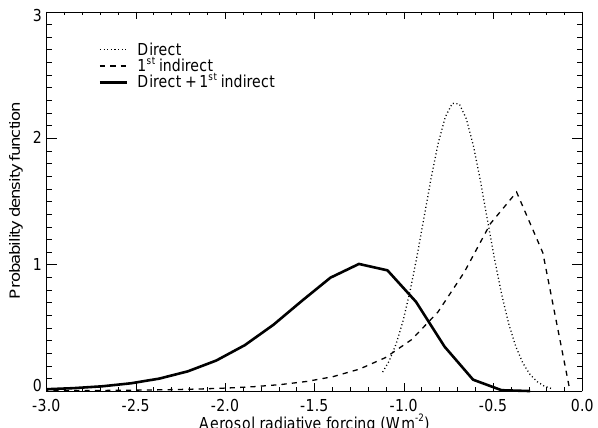
Fig. 6. Probability density functions of direct (dotted line) and first indirect (dashed line) aerosol radiative forcing, and their sum (solid line), for the period 2003–2010. See Sect. 7 for the description of the Monte-Carlo method used to derive those functions. Radiative forcings are for the shortwave spectrum only and given in Wm − 2 .